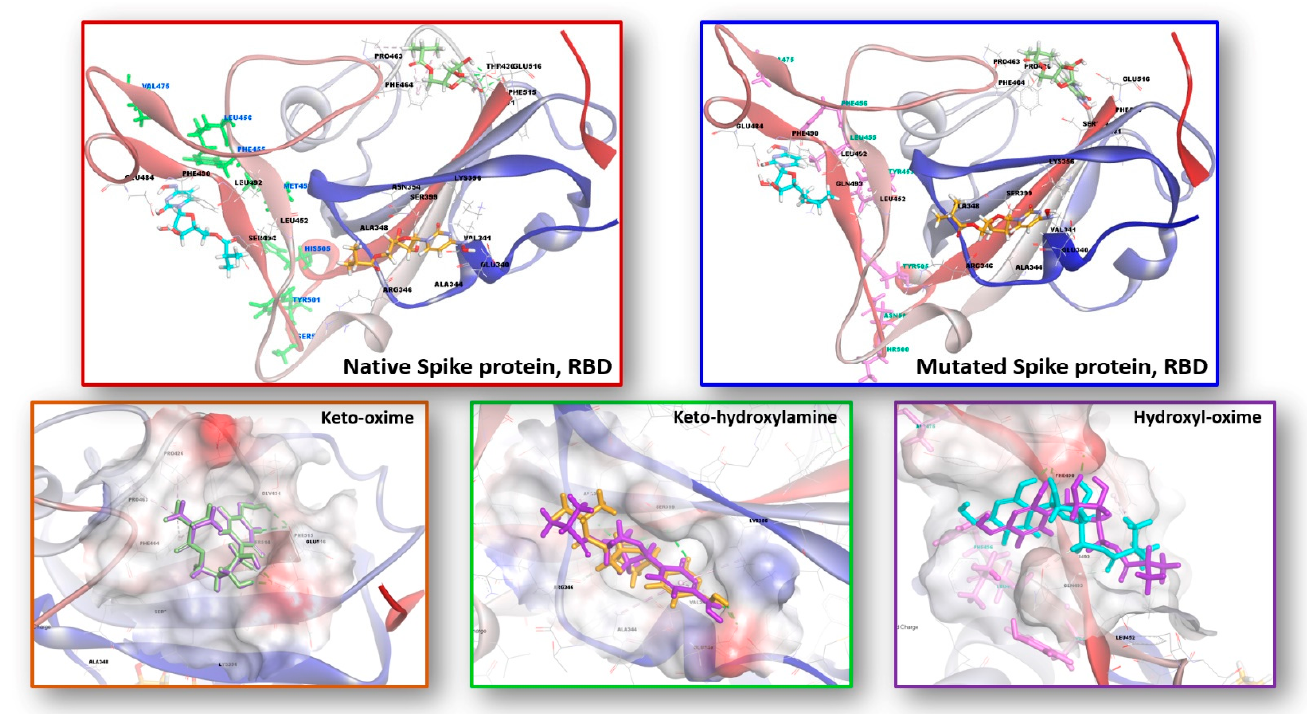
Figure 9. Interaction of the keto-oxime (green), keto-hydroxylamine (orange), and hydroxyl-oxime (cyan) tautomers of molnupiravir with the native (top left) and mutated (top right) Spike proteins, RBD. Behaviors of tautomers of molnupiravir towards native and mutated Spike proteins, RBD of SARS-CoV-2. The bottom row depicts the superimposed binding poses of the reported tautomers of molnupiravir with the native (purple) and mutated (green, orange and cyan) Spike proteins, RBD.